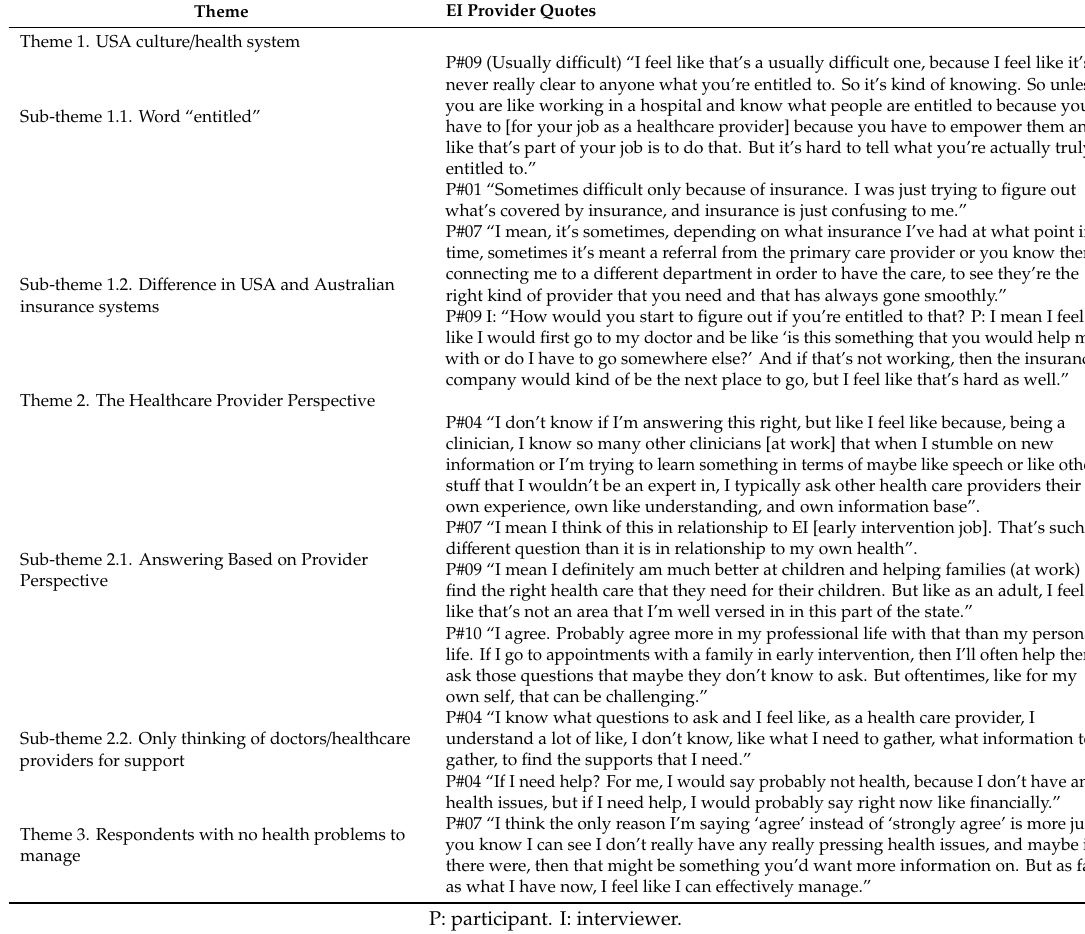
Table 4. Additional examples of not matching or discordance for themes 1, 2, and